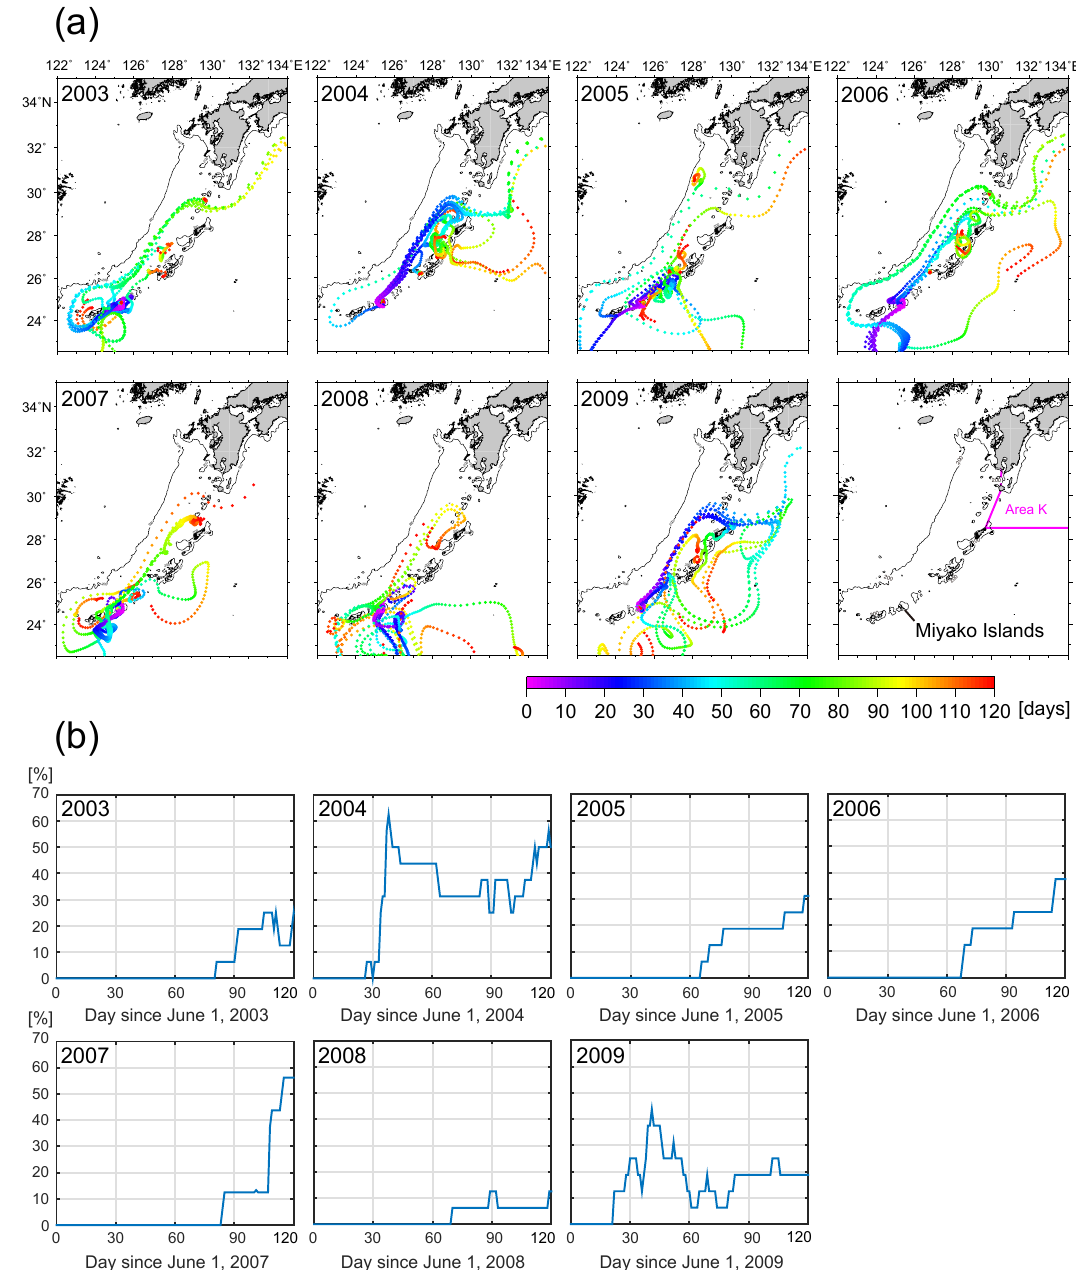
Figure 7. (a) Trajectories of particles released from points around the Miyako Islands on 1 June, 2003–2009. (b) The ratio of particles delivered to Area K to the total released